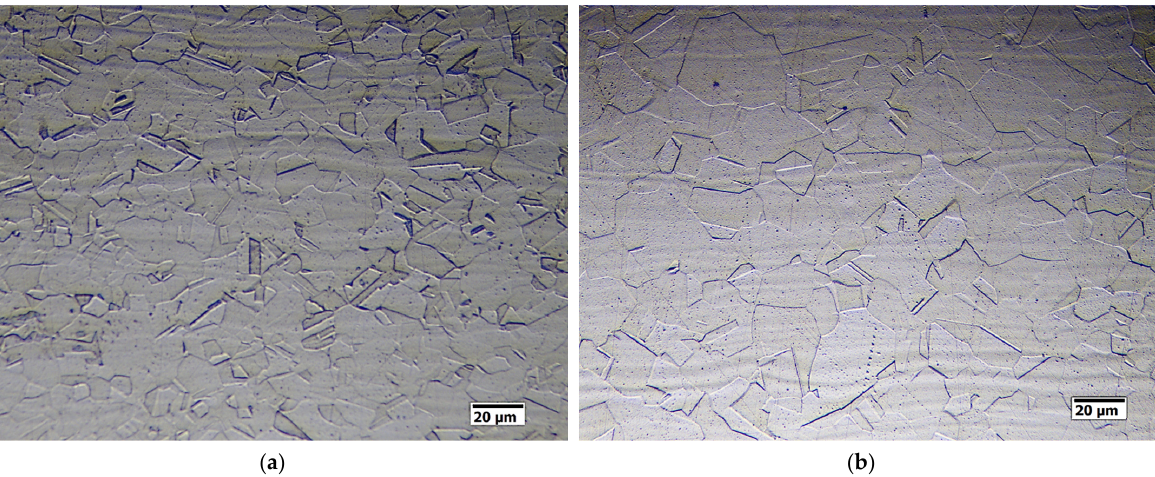
Figure 6. AISI 904L steel after cold rolling at 50% and annealing at ( a ) 1050 °C for 40 s and ( b ) 1150 °C for 20 s.